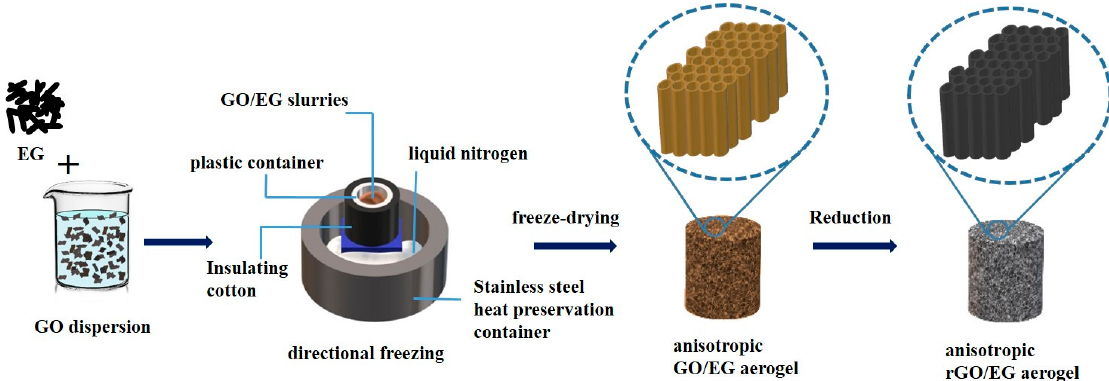
Figure 1. Flow chart of anisotropic reduced graphene oxide (rGO)/expanded graphite (EG) aerogel produced by directional freezing.